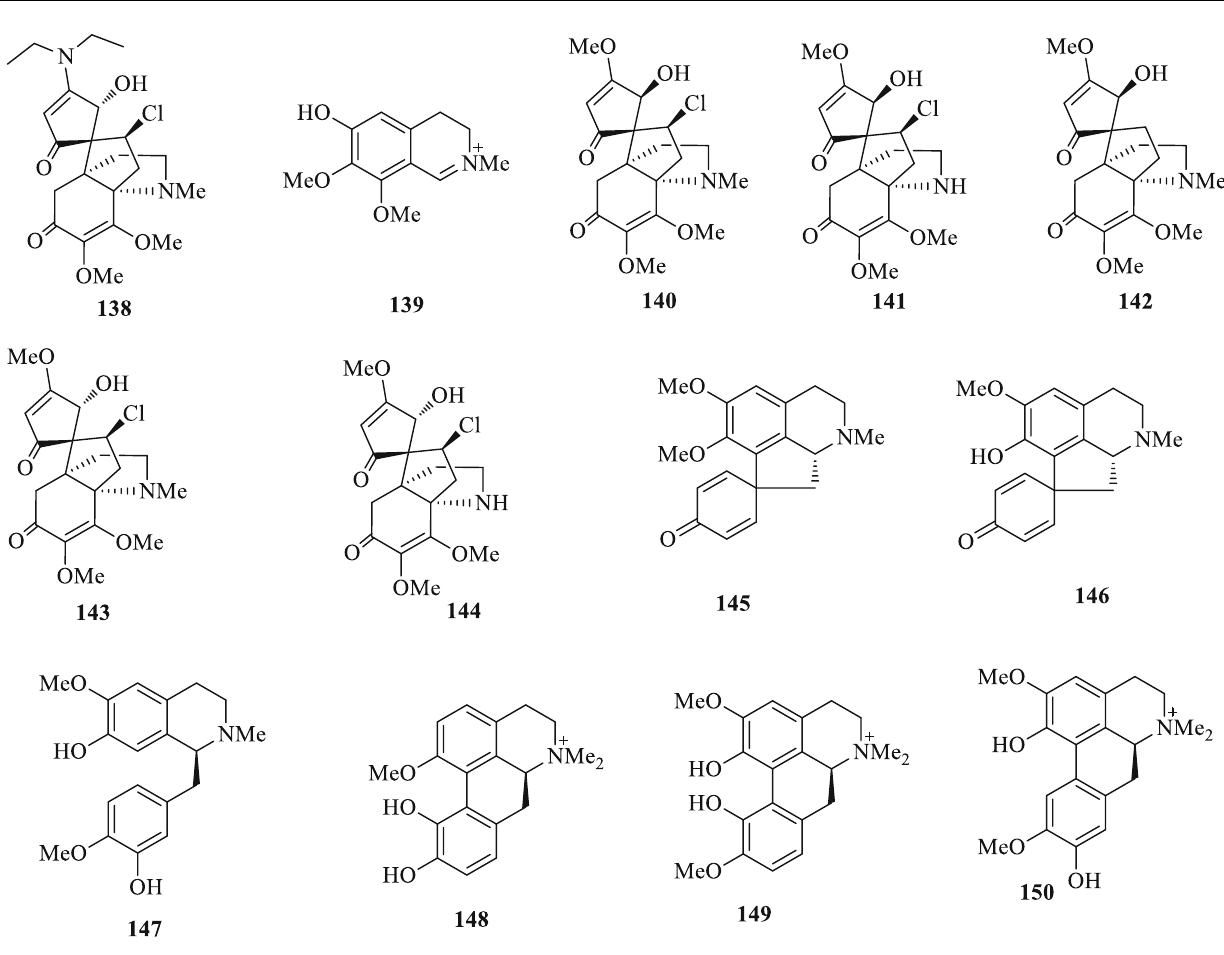
Fig. 9 Structures of compounds 138 –